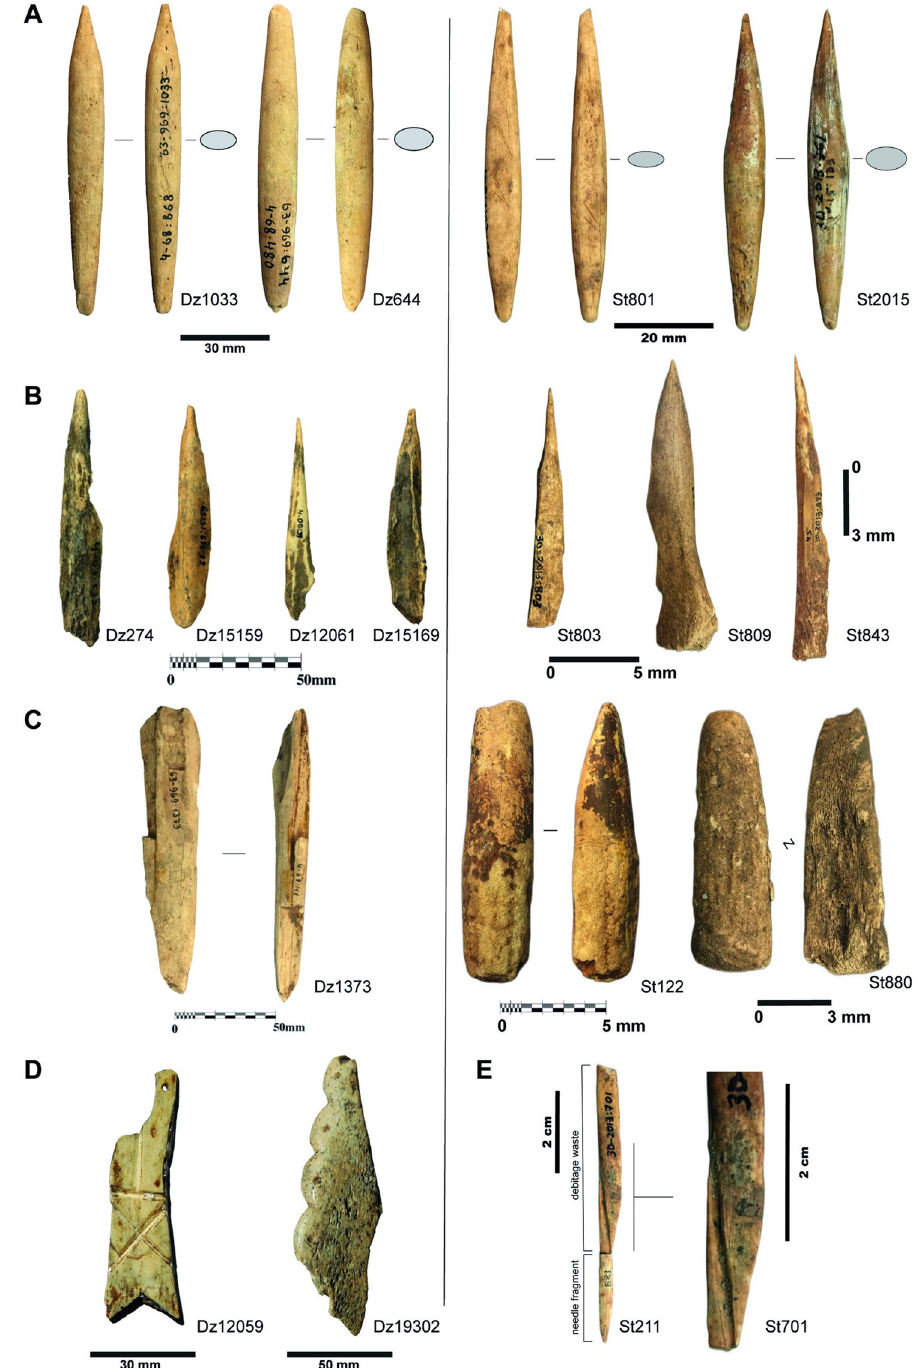
Fig 3. Bone tools examples from Dzudzuana (left) and Satsurblia (right). Projectile points (A); awls (B); ‘intermediate pieces’ (chisels) (C); notched and incised bone fragments from Dzudzuana (D); bone needle from Satsurblia and debitage waste linked with needle production (E). Specimens housed at the prehistory storage facilities of the Georgian State Museum (Tbilisi, Georgia). Photos by J.-M. Tejero.